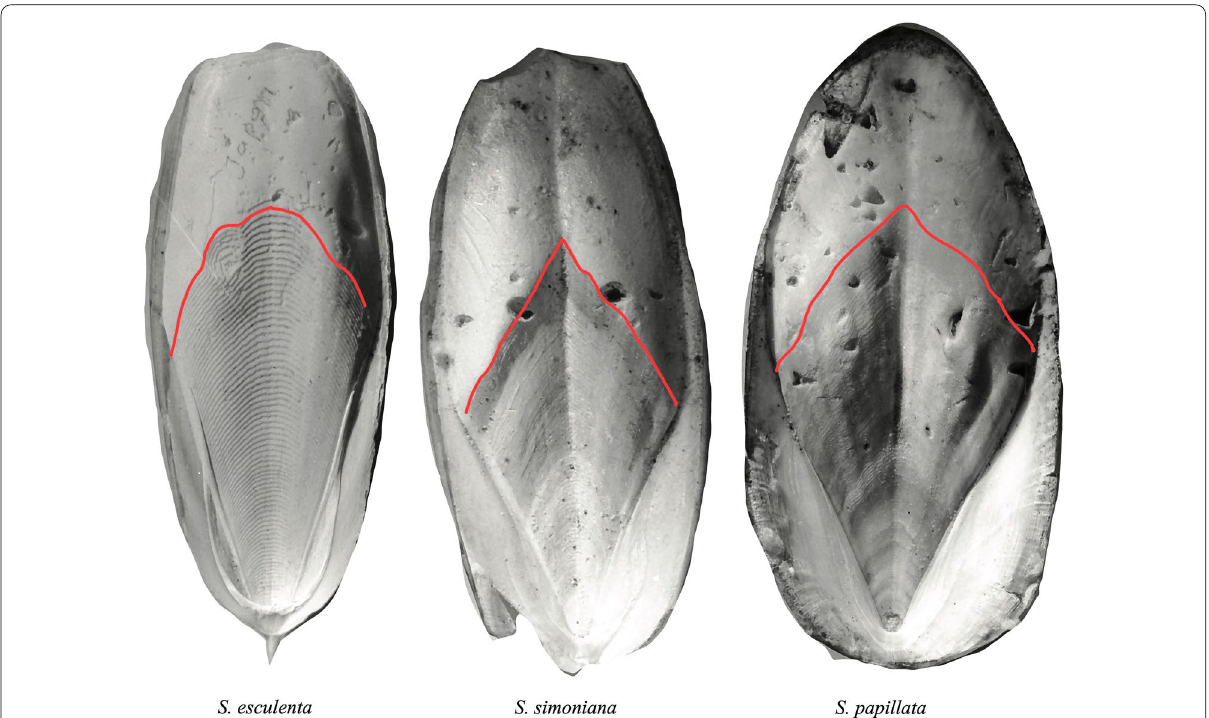
Fig. 8 Shallow water sepiids. Broad, flat, low septal density. The last loculus makes up a significant proportion of the total phragmocone volume; the overall sepion is flat for its width; the dorsal side of sepion has no ribbing for strengthening. Red line shows position of last loculus contact with siphuncular